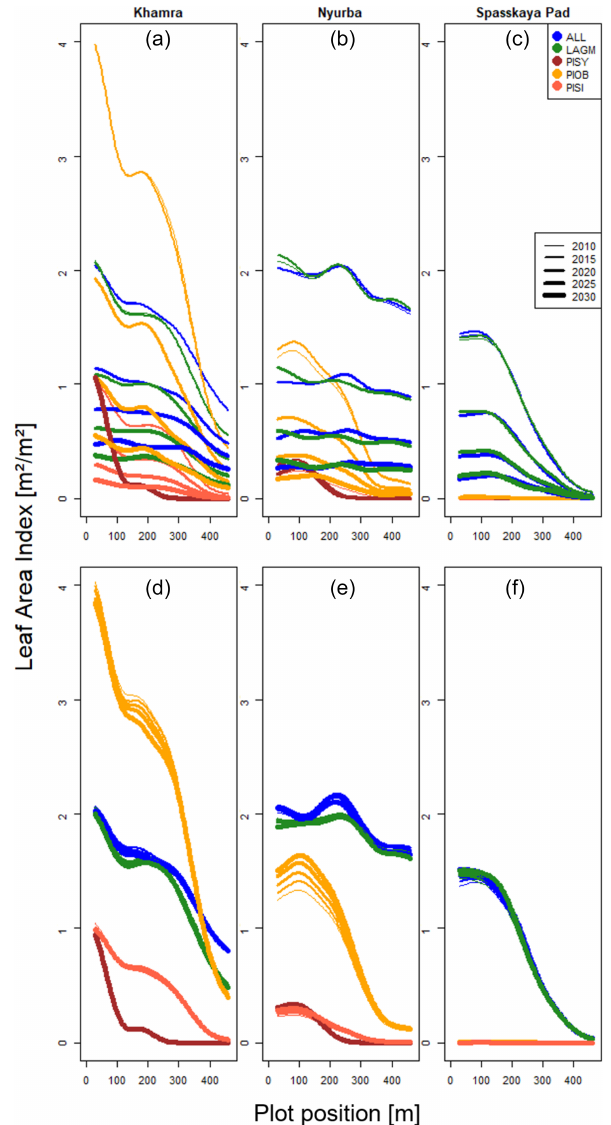
Figure E1. Mean leaf area index aggregated east–west for each simulated focus area and time slice (2010–2030). Upper row shows LAVESI–CryoGrid coupled version; lower row shows only